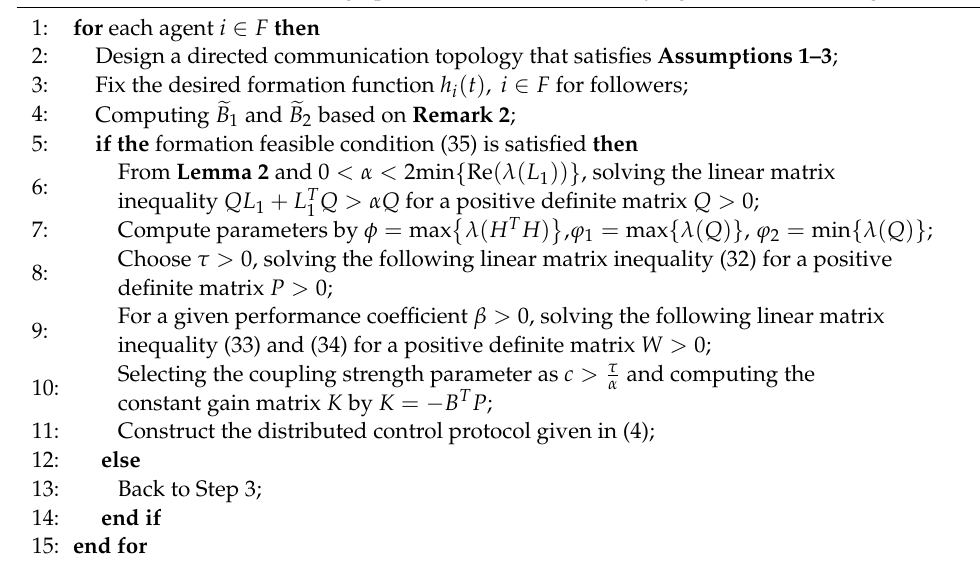
Algorithm 2 Procedures to design parameters for H 2 time-varying formation